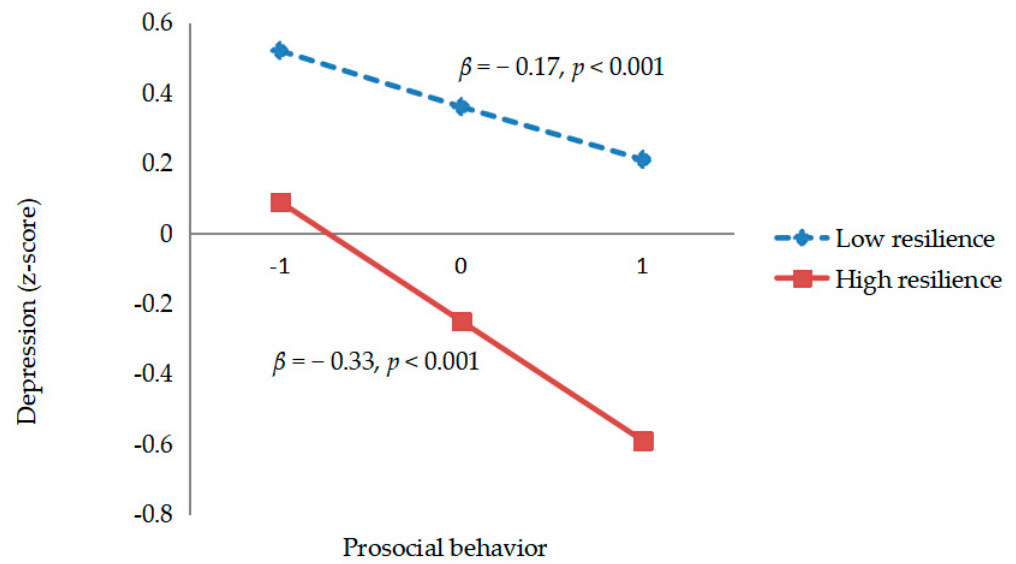
Figure 2. Simple regression lines of prosocial behavior on depression under different levels of resilience. Note: the X-axis represents the level of prosocial behavior; the Y -axis represents the z-score of depression; resilience was divided into two groups: low ( − 1 SD ) and high (+1 SD ) levels.